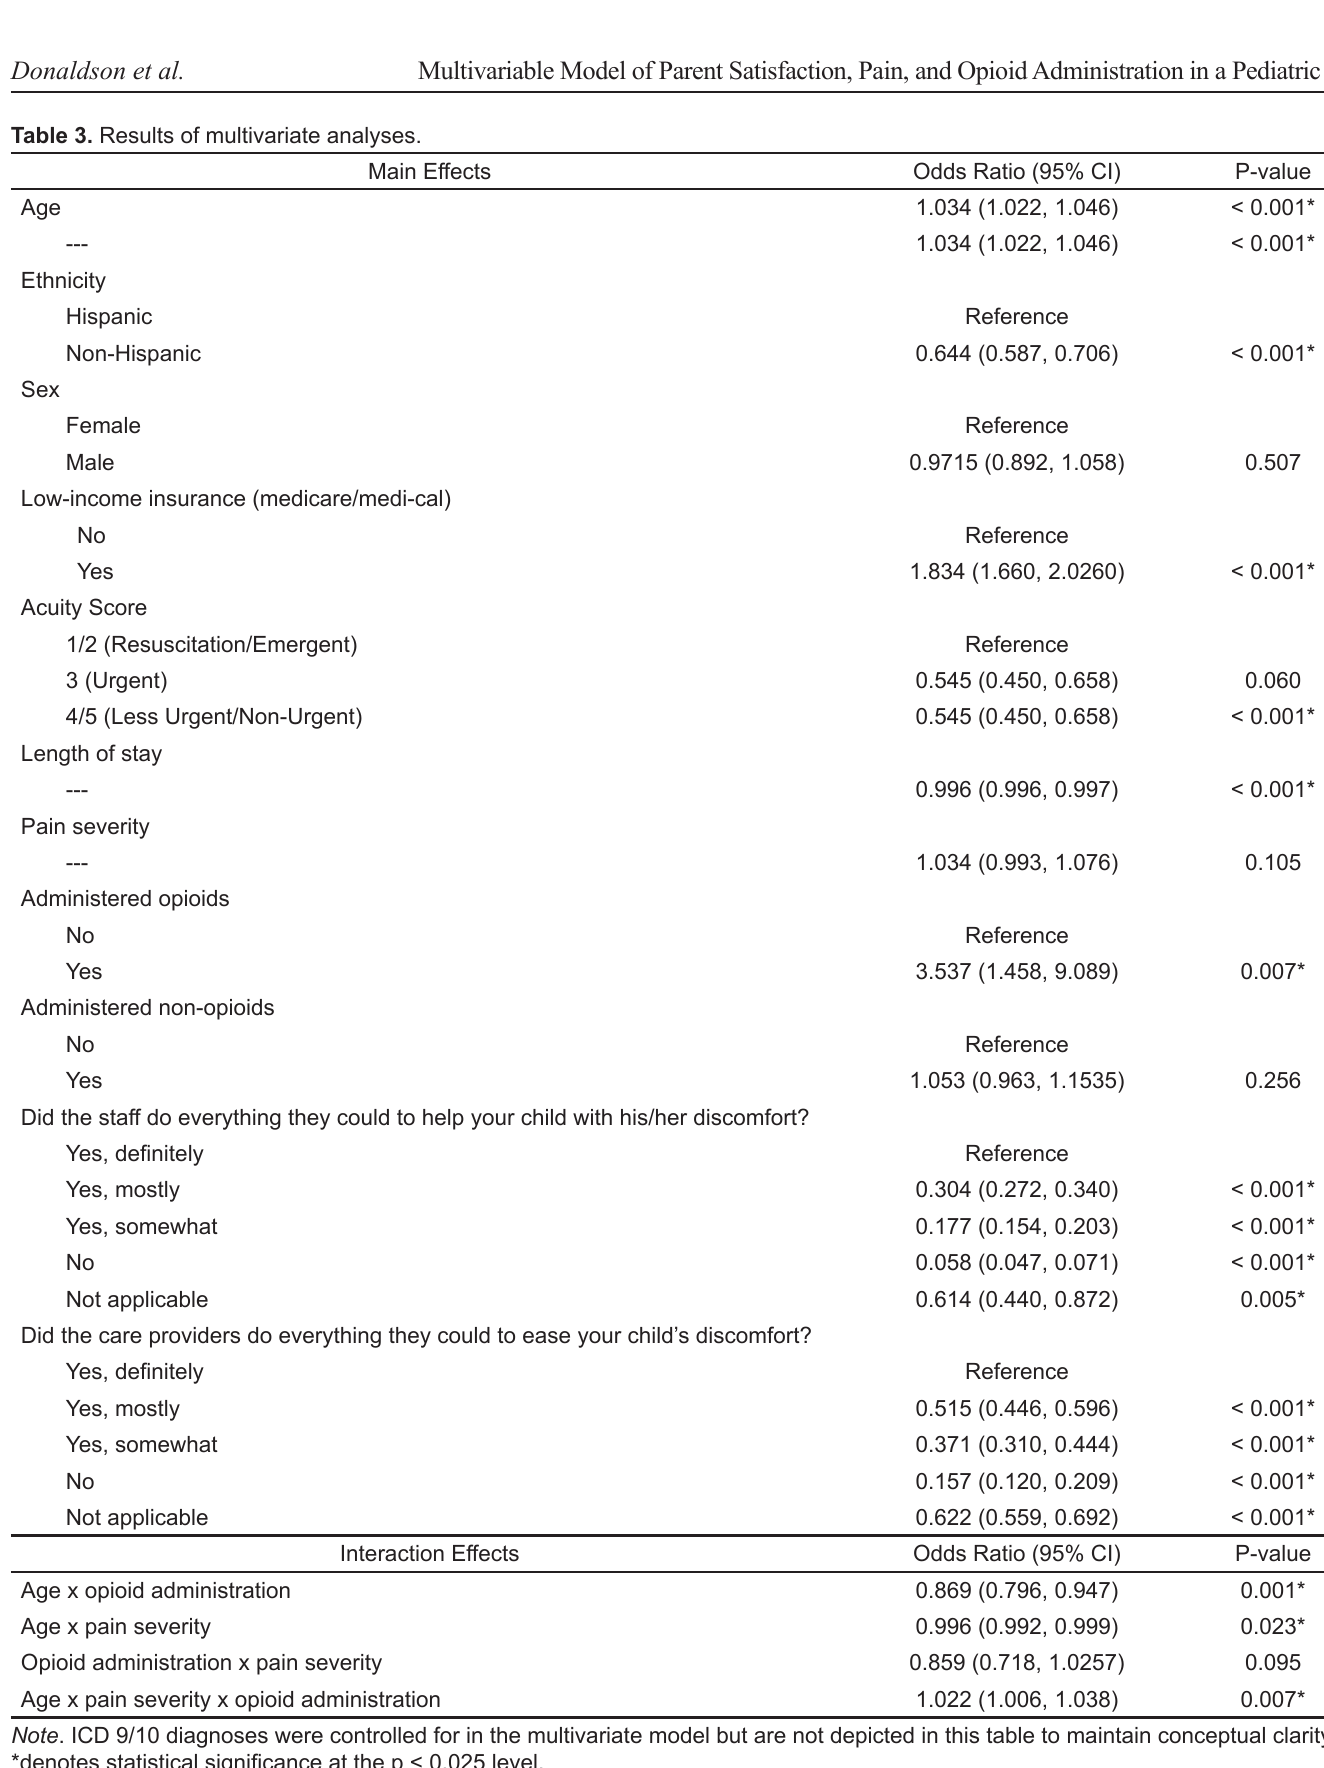
Table 3. Results of multivariate